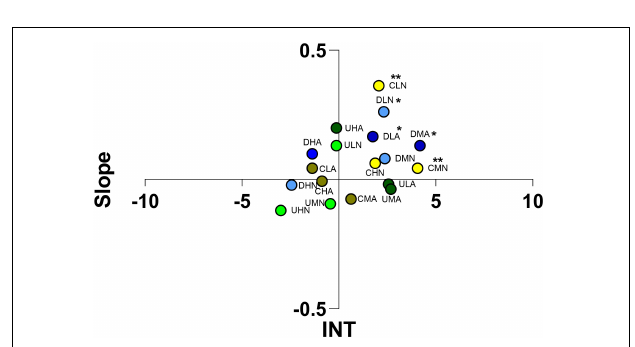
FIGURE 10 | Ordination into 1 of 4 sectors of Idotea balthica juveniles according to the scores reached for “Slope” and “INT” (integral time) in static arenas. The letters indicate the algae considered (C, Cocconeis scutellum var. parva ; D, Diploneis sp.; U, Ulva prolifera ), the concentration of VOCs (L, low; M, medium; H, high), and the culture and test conditions (N, normal conditions, A, acidified conditions). Asterisks indicate the significance of individuals’ position in the